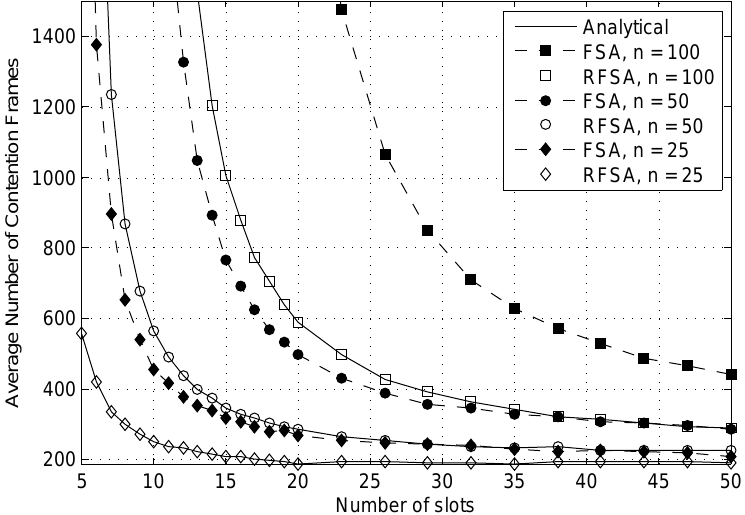
Figure 3. Average delay (in frames) required to terminate a data collection round over the frame